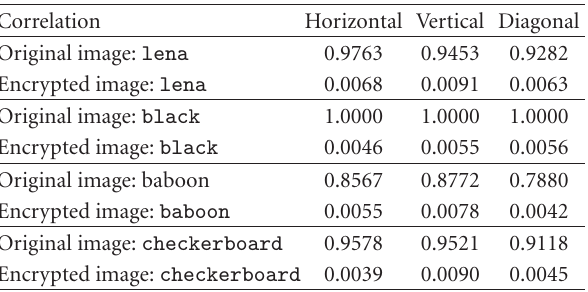
Table 3: Correlation coe ffi cients between adjacent pairs of pixels for original and encrypted